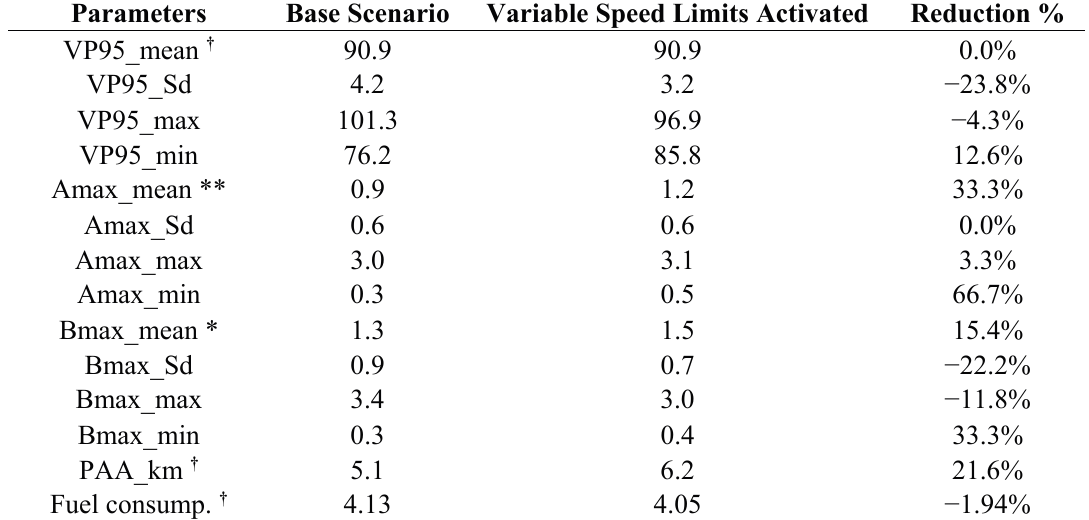
Table 4. Changes in vehicle trajectory variables produced by the activation of a Variable Speed Limit system.